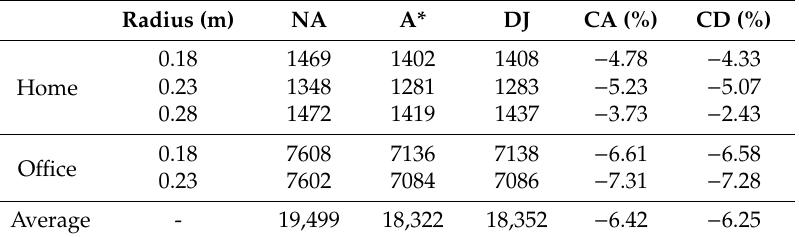
Table 7. Results of path